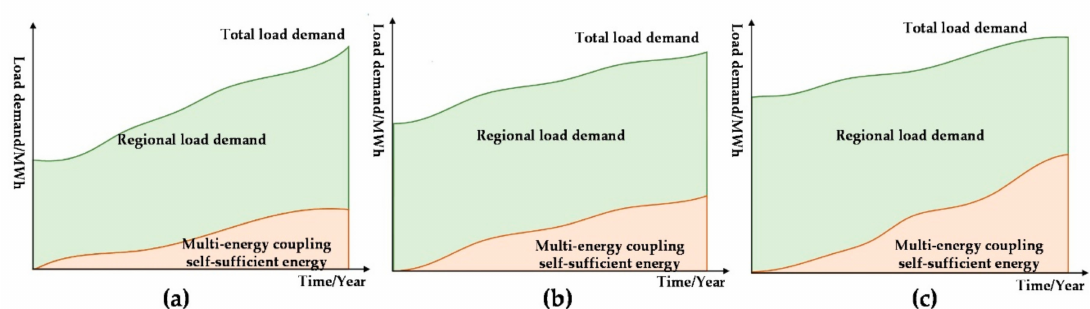
Figure 1. Relative changes of load demand under the scenario of multi-energy coupling. ( a ) Scenarios in which multiple coupling technologies are evolving slowly; ( b ) Scenarios in which multiple coupling technologies are developing at a moderate rate; ( c ) Scenarios in which multiple coupling technologies are evolving